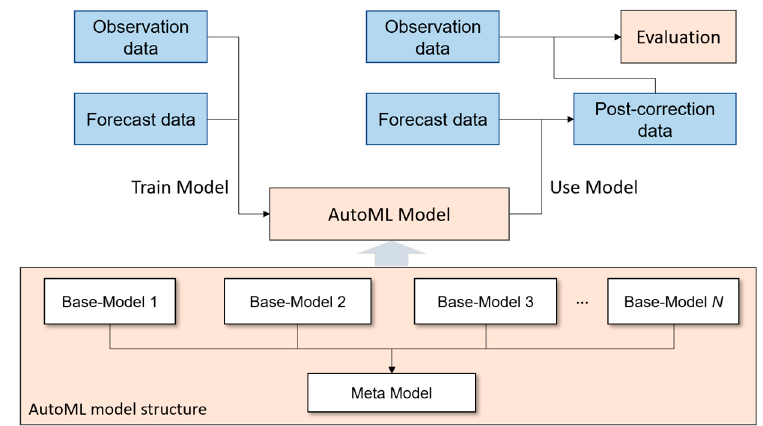
Figure 3. Stacking ensemble Auto-ML model framework.